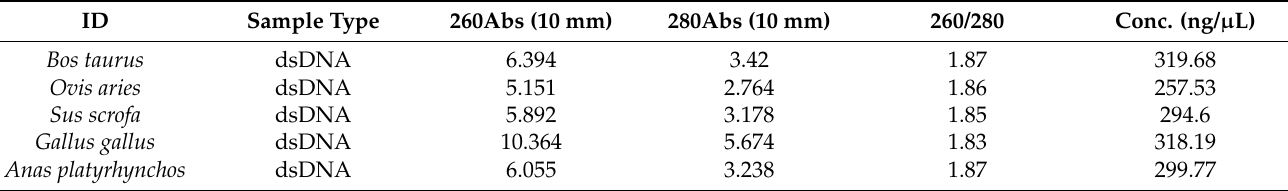
Table 3. Determination of DNA concentration.